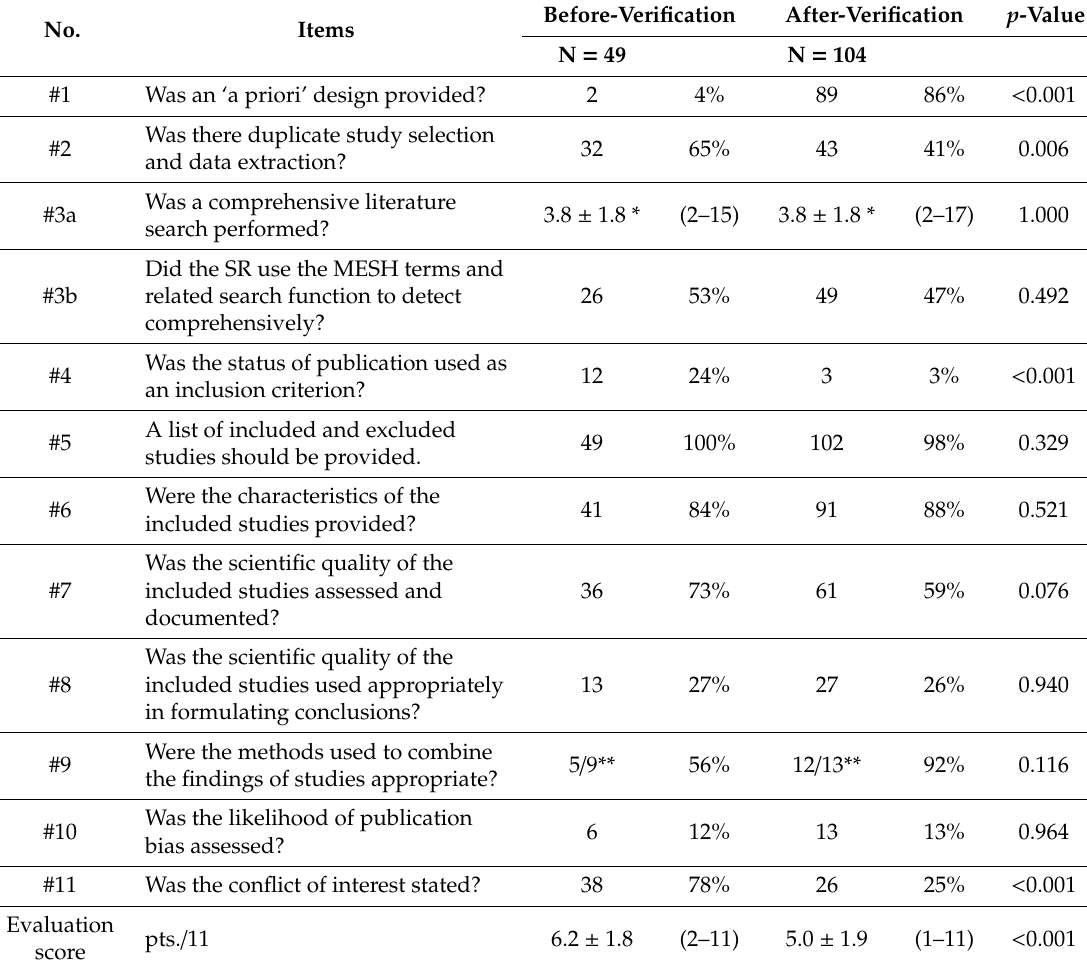
Table 3. Quality assessment of systematic reviews (SR) of the foods with function